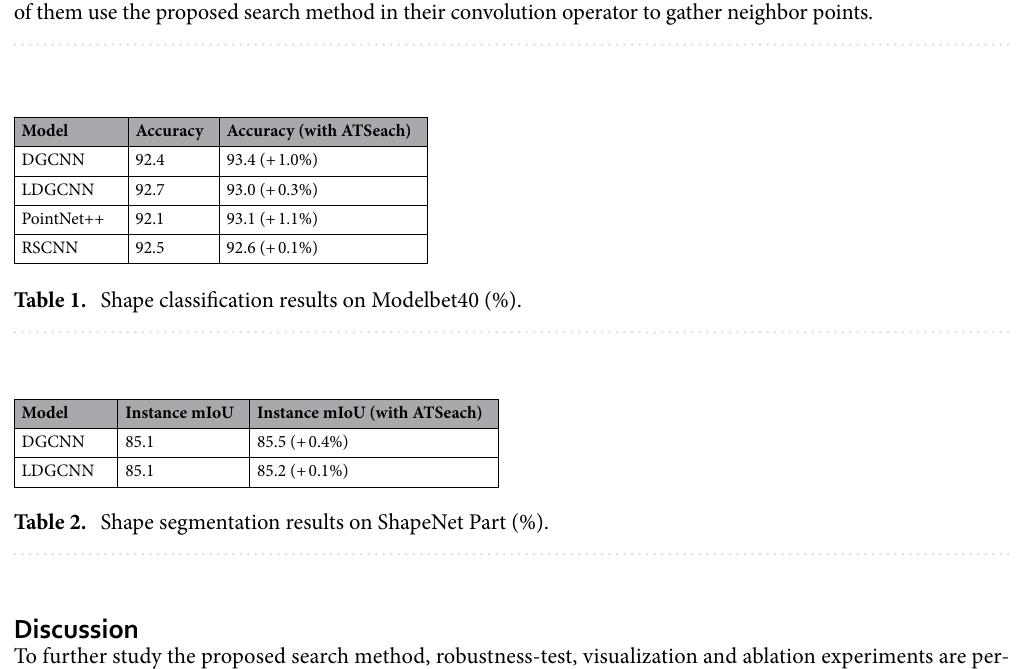
Figure 4. Top: ATDGCNN used for classification task; Bottom: ATDGCNN used for segmentation task. Both of them use the proposed search method in their convolution operator to gather neighbor points.